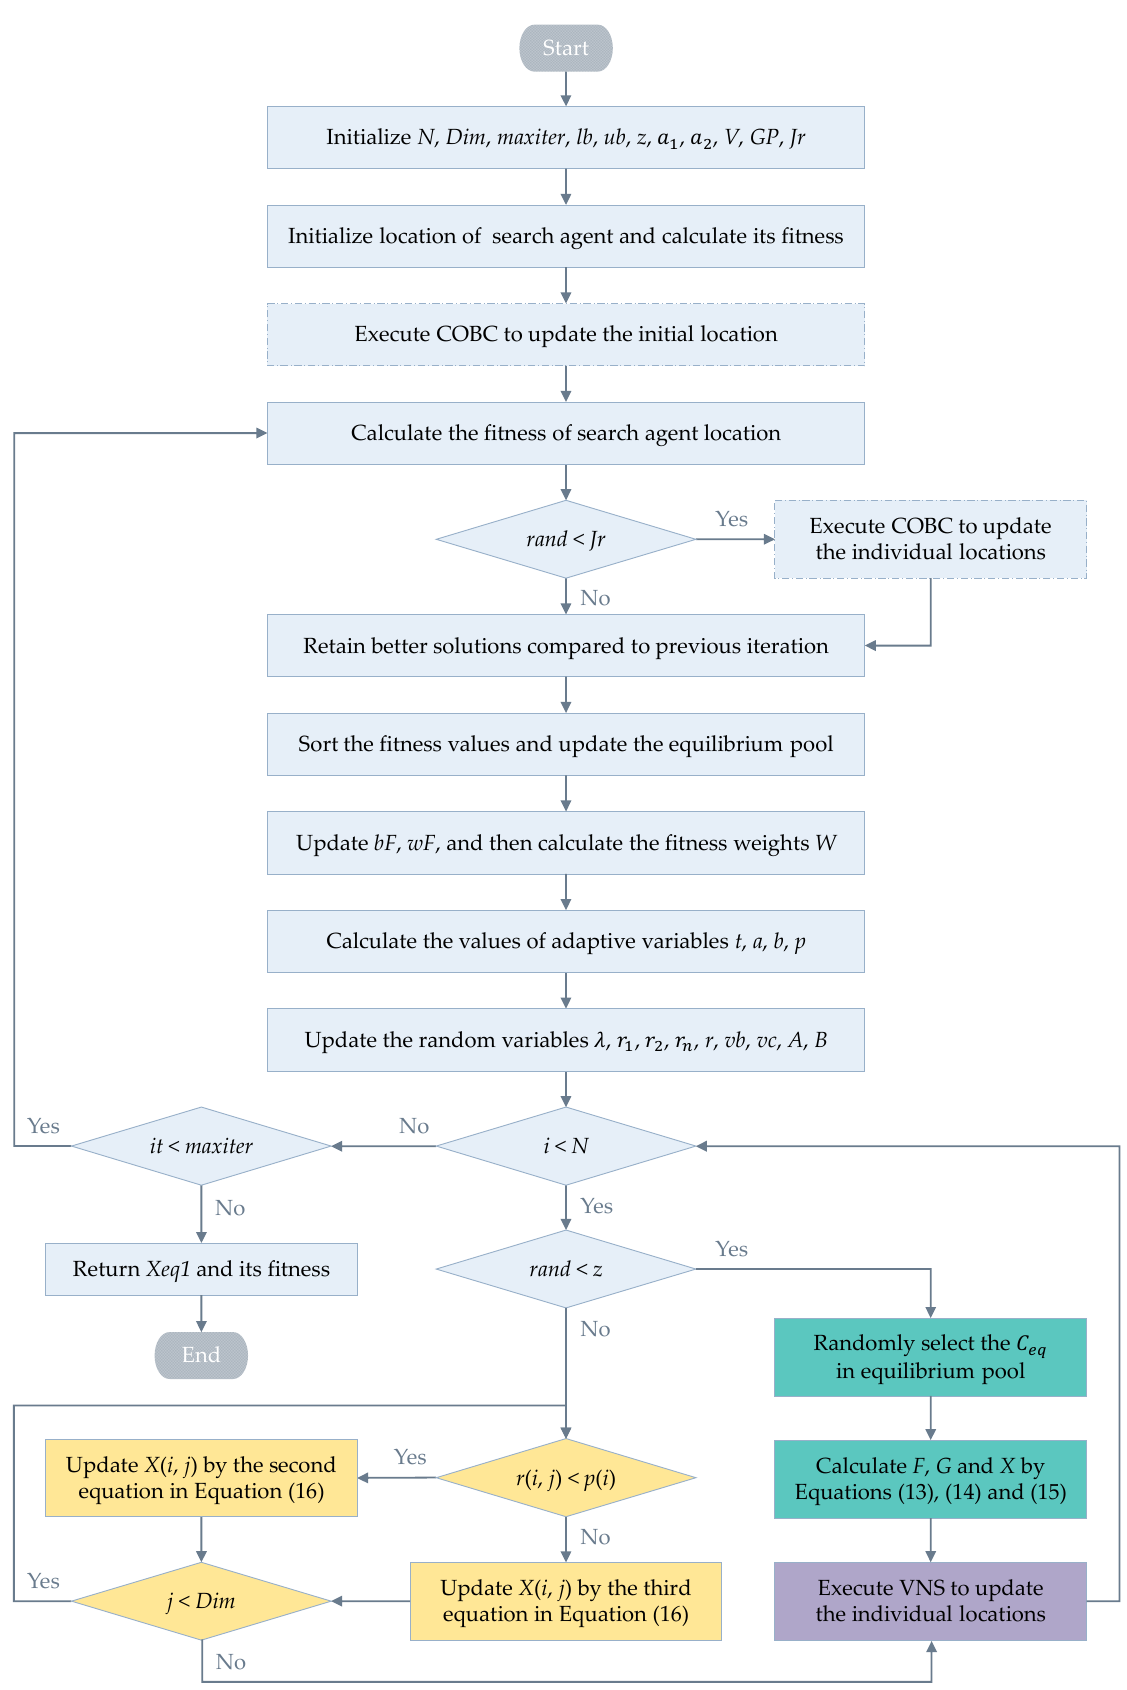
Figure 4. Flow chart of the EOSMA for JSSP.